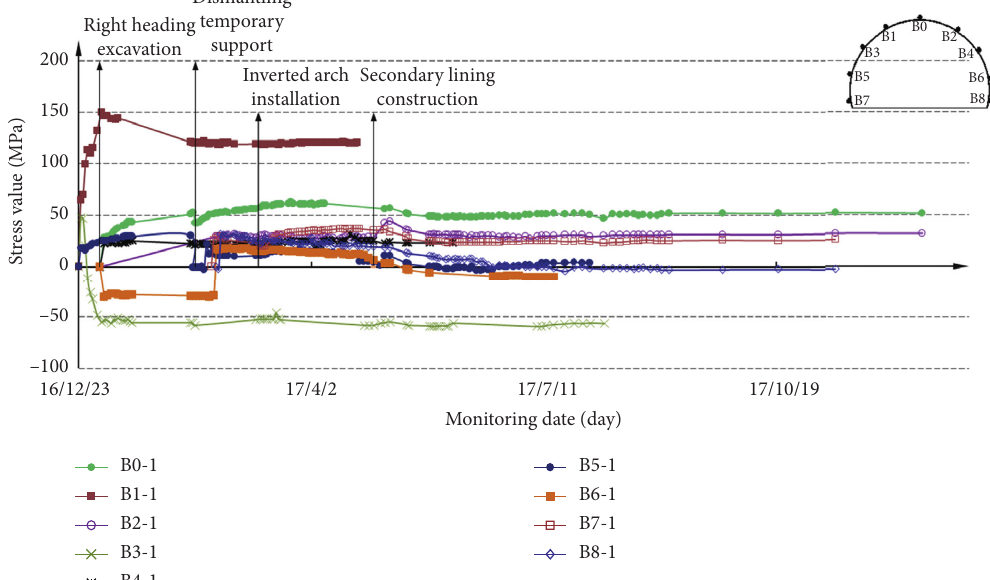
Figure 10: Stress temporal curves at the outside of steel rib at section YK2+449.